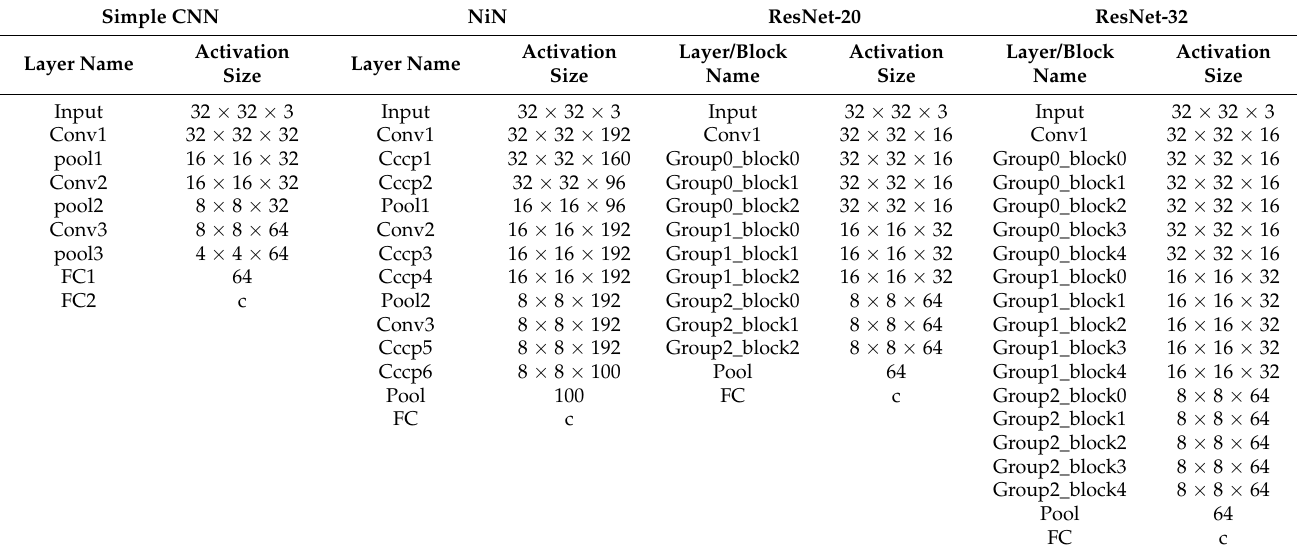
Table 1. Size of activations at the output of every layer or block for all utilized CNN architectures for 32 × 32 px input